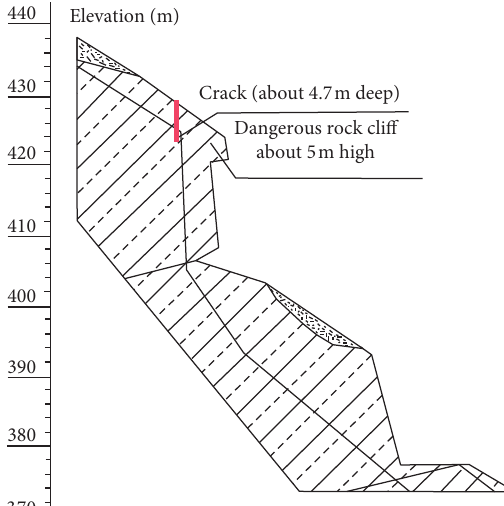
Figure 7: Falling-type dangerous rock mass of W